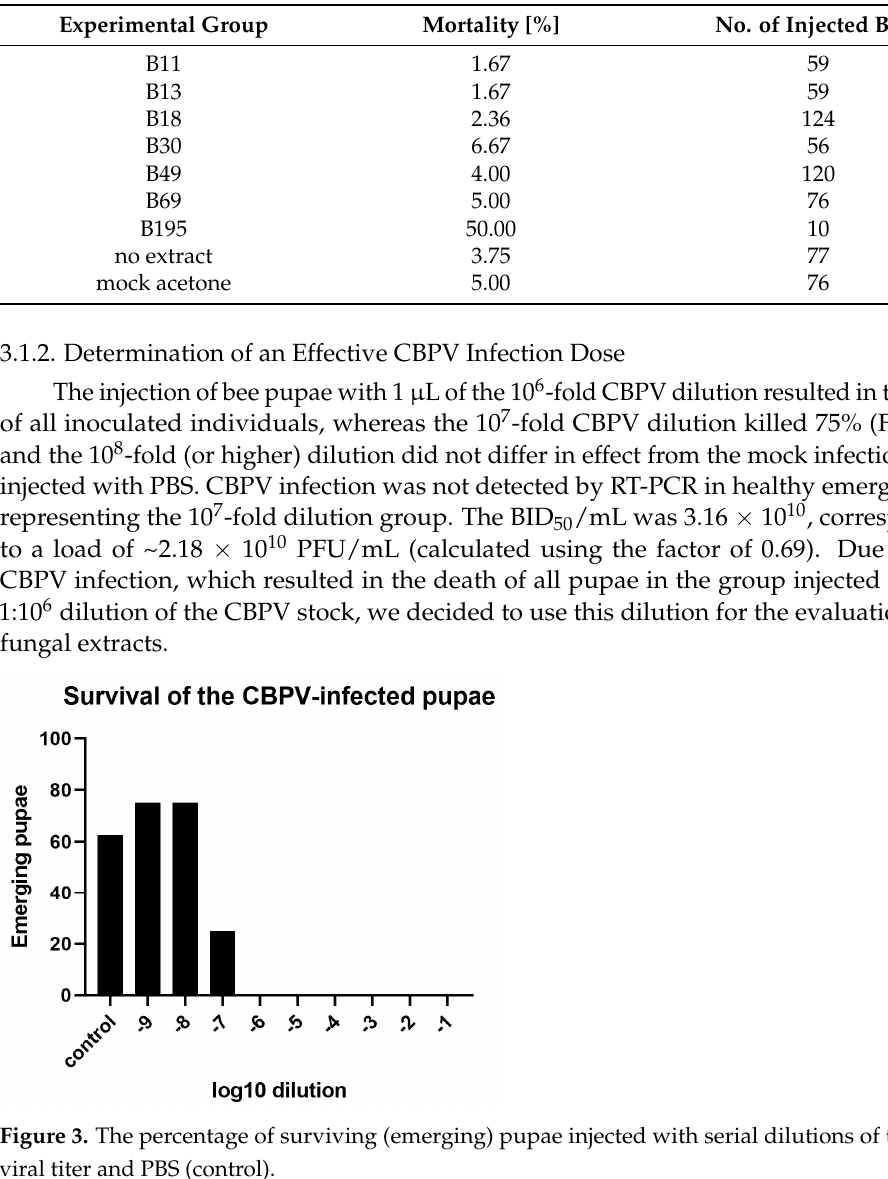
Table 2. The mortality of bees fed on sugar solution enriched with fungal crude extracts before the CBPV injection or the solvent (80% acetone) in the mock group (followed by mock infection) or no extract in the no extract group (followed by CBPV injection).